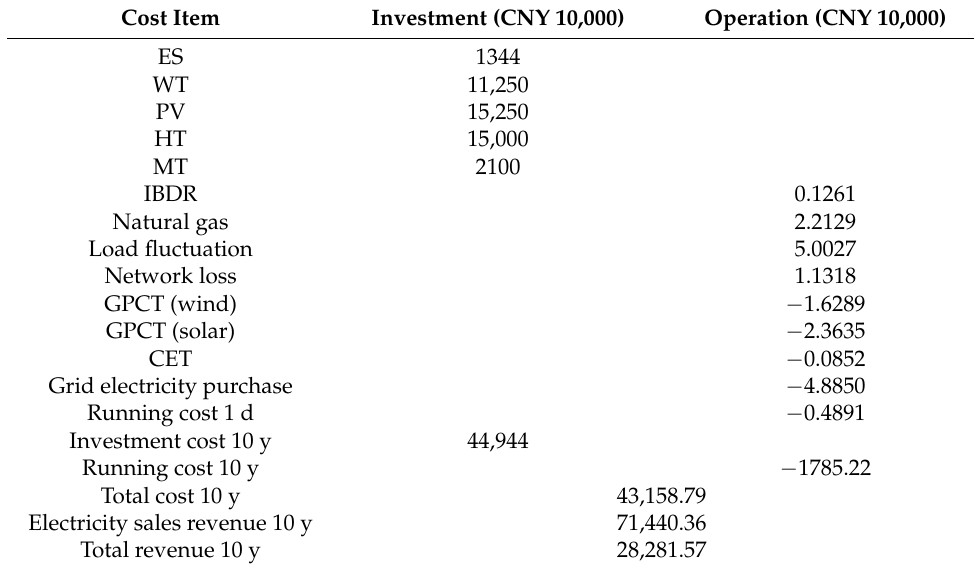
Table 2. IEEE33 NDN planning and simulation operation cost considering GPCT and